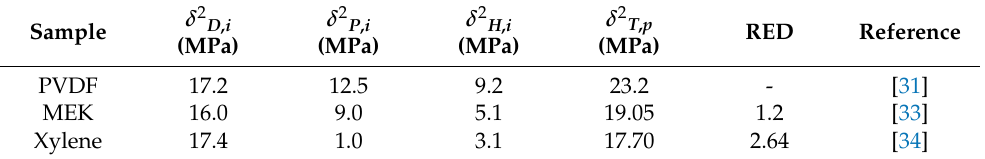
Table 3. Hansen solubility parameters (HSP) values for PVDF, methyl ethyl ketone (MEK), and xylene.